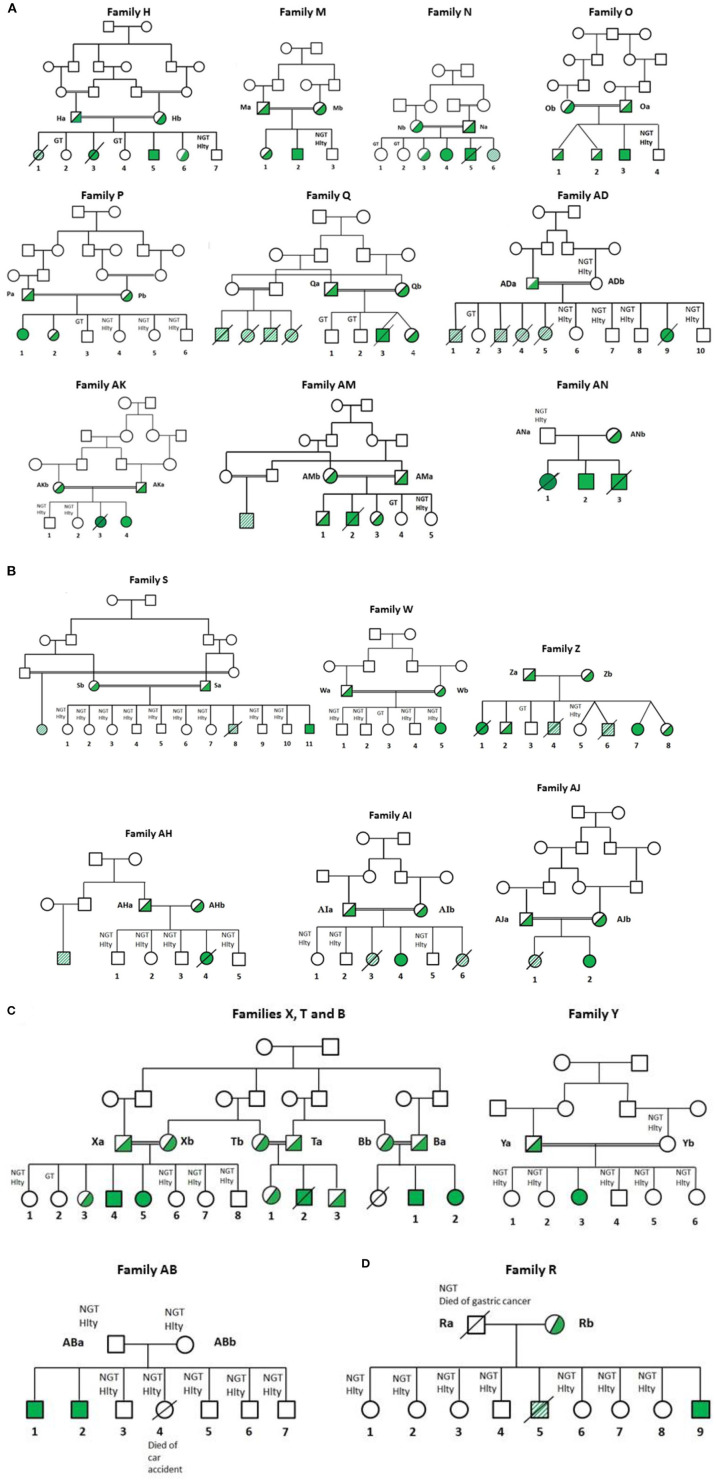
Pedigree of Jordanian, Lybian, and Iraqi families. CGD was diagnosed by measurement of NADPH oxidase activity in neutrophils as described in Patients and Methods. All families contained consanguineous marriages, except families R, Z, AB, AH, and AN. Diagonal shaded box: highly suspicious but functionally and genetically not tested (H1, R5, S8, Z6, Z4, AD1, AD3, AD4 and AD5, AI3 and AJ1). Hlty, healthy; NGT, not genetically tested; GT, genetically tested; Open symbols: no mutation in CGD genes among the tested members; filled symbols: homozygous for the CGD mutations; half-filled symbols: heterozygous for the mutation; cross-out symbols: deceased patients. (A) CGD patients from families H, M, N, O, P, Q, AK, AM, AN, and AD suffering from AR670 CGD. (B) CGD patients from families S, W, Z, AH, AI, and AJ suffering from AR220 CGD. (C) CGD patients from families T, Y, X, and AB suffering from AR470 CGD. T and X are related families. These families were also related to family B (21). (D) CGD patients from family R suffering from X0 CGD.